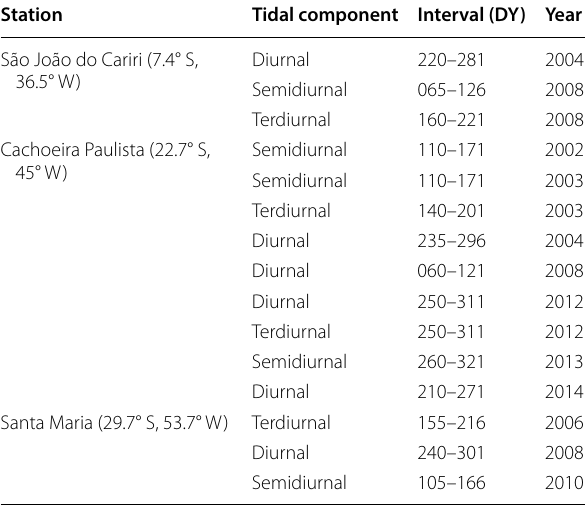
Table 1 Details of the selected intervals showing evident signature of the 27-day modulation of the tidal amplitude in the zonal wind